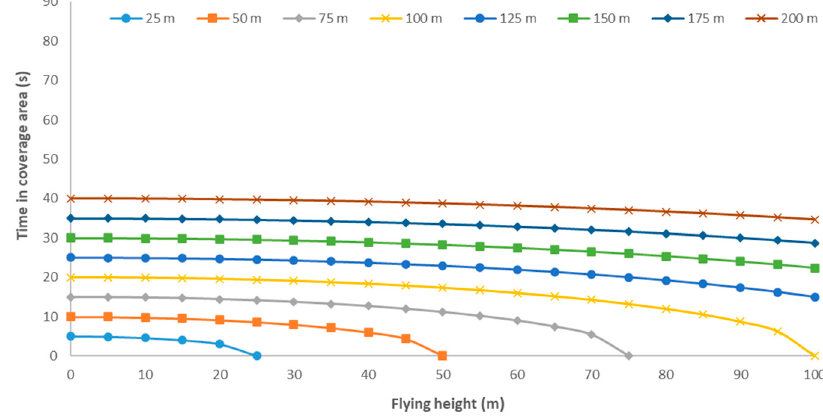
Figure 11. Time in coverage when a drone flies at 10 m/s and different dc .